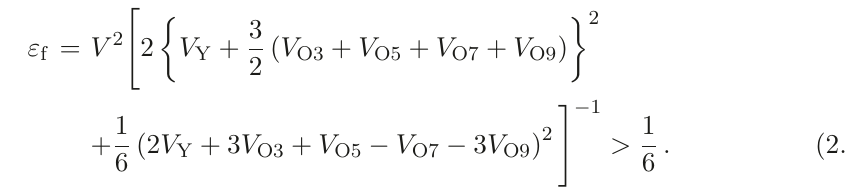
Figure 4 . We fix R (Y) = 0, A H = A p = A D p = 0, and A O p set κ = 1. in the moduli potential (2.12) for the type IIA theory. We depicted the behavior of the parameters ε f (¯ τ, ¯ ρ ), η f (¯ τ, ¯ ρ ). Our setup cannot describe the ekpyrotic scenario because the background does not obey the fast-roll condition